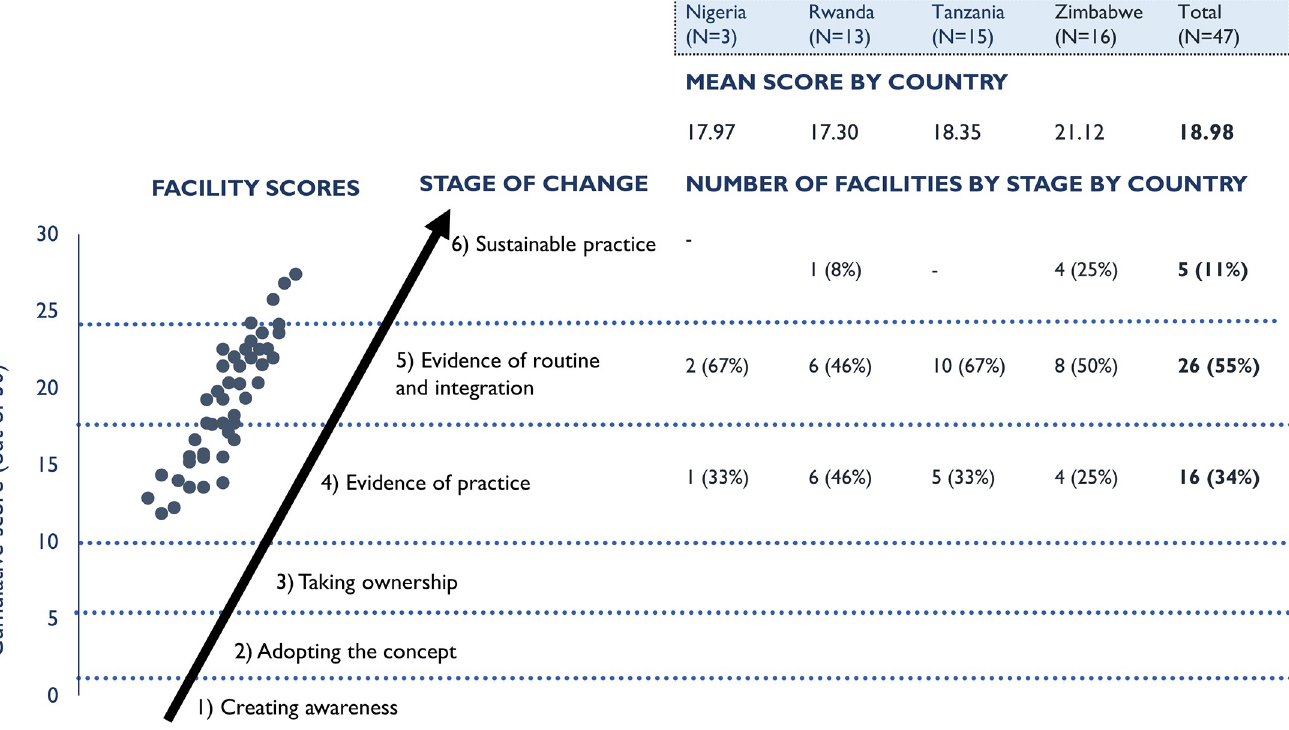
Fig 2. Implementation progress score and distribution of facilities by